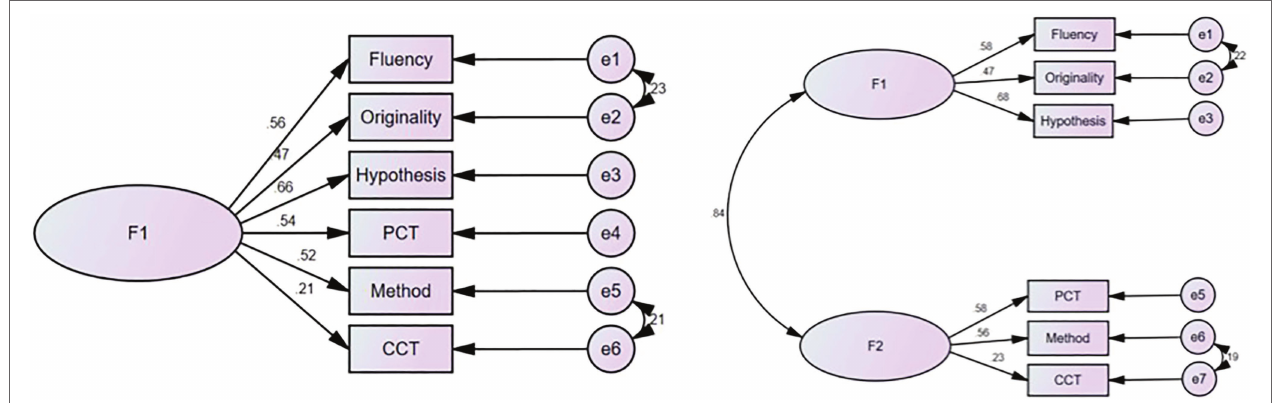
FIGURE 1 | The comparison of the two confirmatory factor analysis (CFA) models: one-factor vs. two-factor.